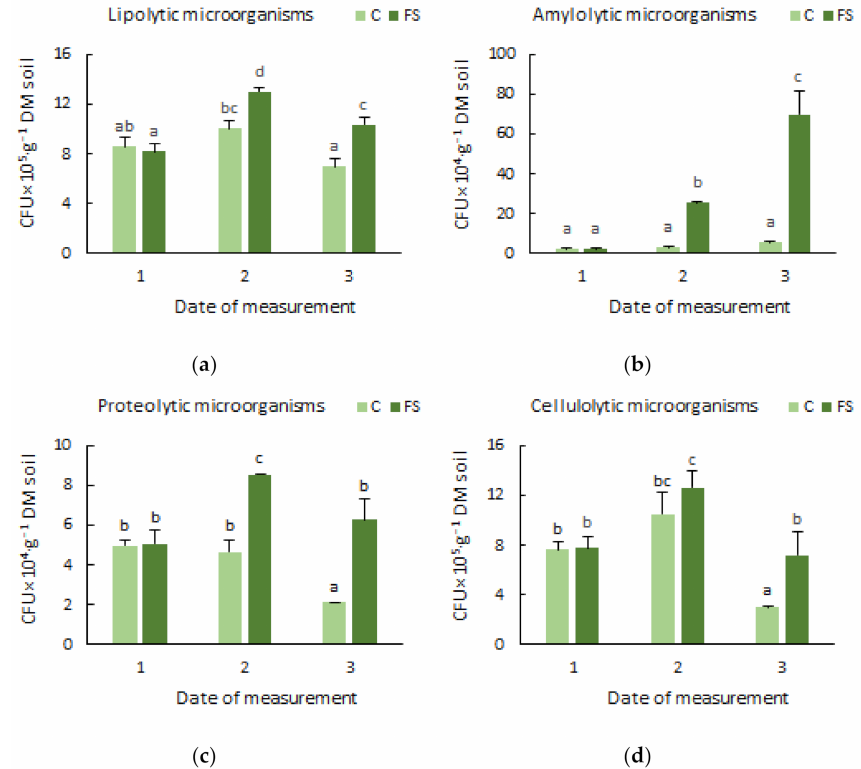
Figure 2. The number of selected metabolic groups of soil microorganisms: ( a ) lipolytic, ( b ) amylolytic, ( c ) proteolytic and ( d ) cellulolytic microorganisms. Different letters above the error bars (i.e., ± SD) indicate significant differences ( p < 0.05) between means (Tukey post-hoc